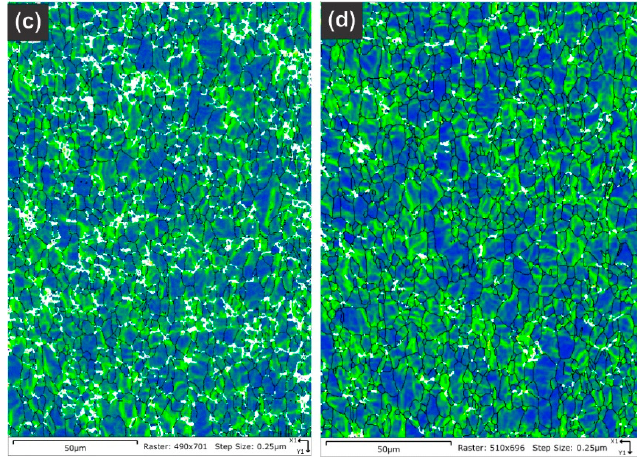
Figure 17. Kernel average misorientation maps are provided for the NPG tubes: ( a ) Tube a-1-05, ( b ) Tube a-2-05, ( c ) Tube d-7-05 and ( d ) Tube d-8-05. Only the sample a-1-05 shows any significant differences, but this is assigned to a poorer final polish rather than any underlying differences in the material as the overall texture and Kearns values were nearly identical between the four samples.